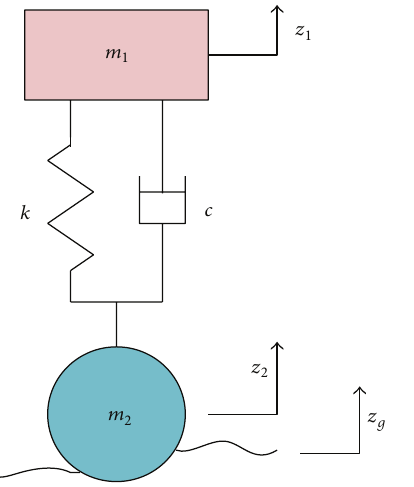
Figure 4: The quarter kinetic model of a manned lunar rover on a deformable